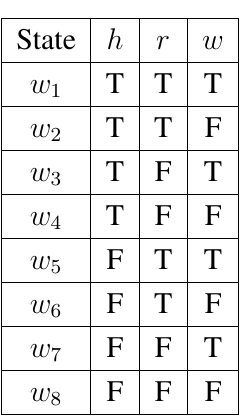
Table 4. Truth Table for 3-Proposition Logical